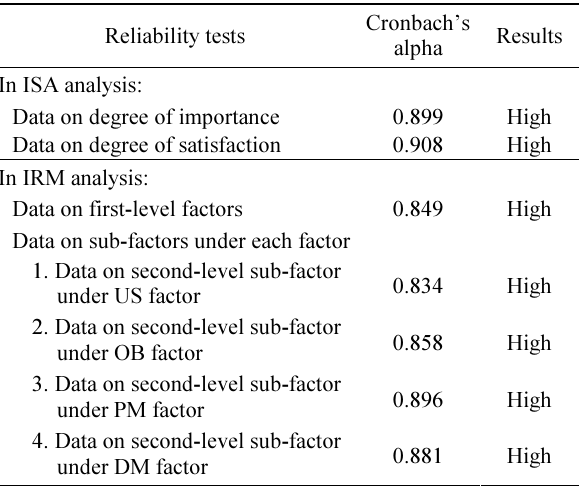
Table 5. Reliability tests on questionnaires